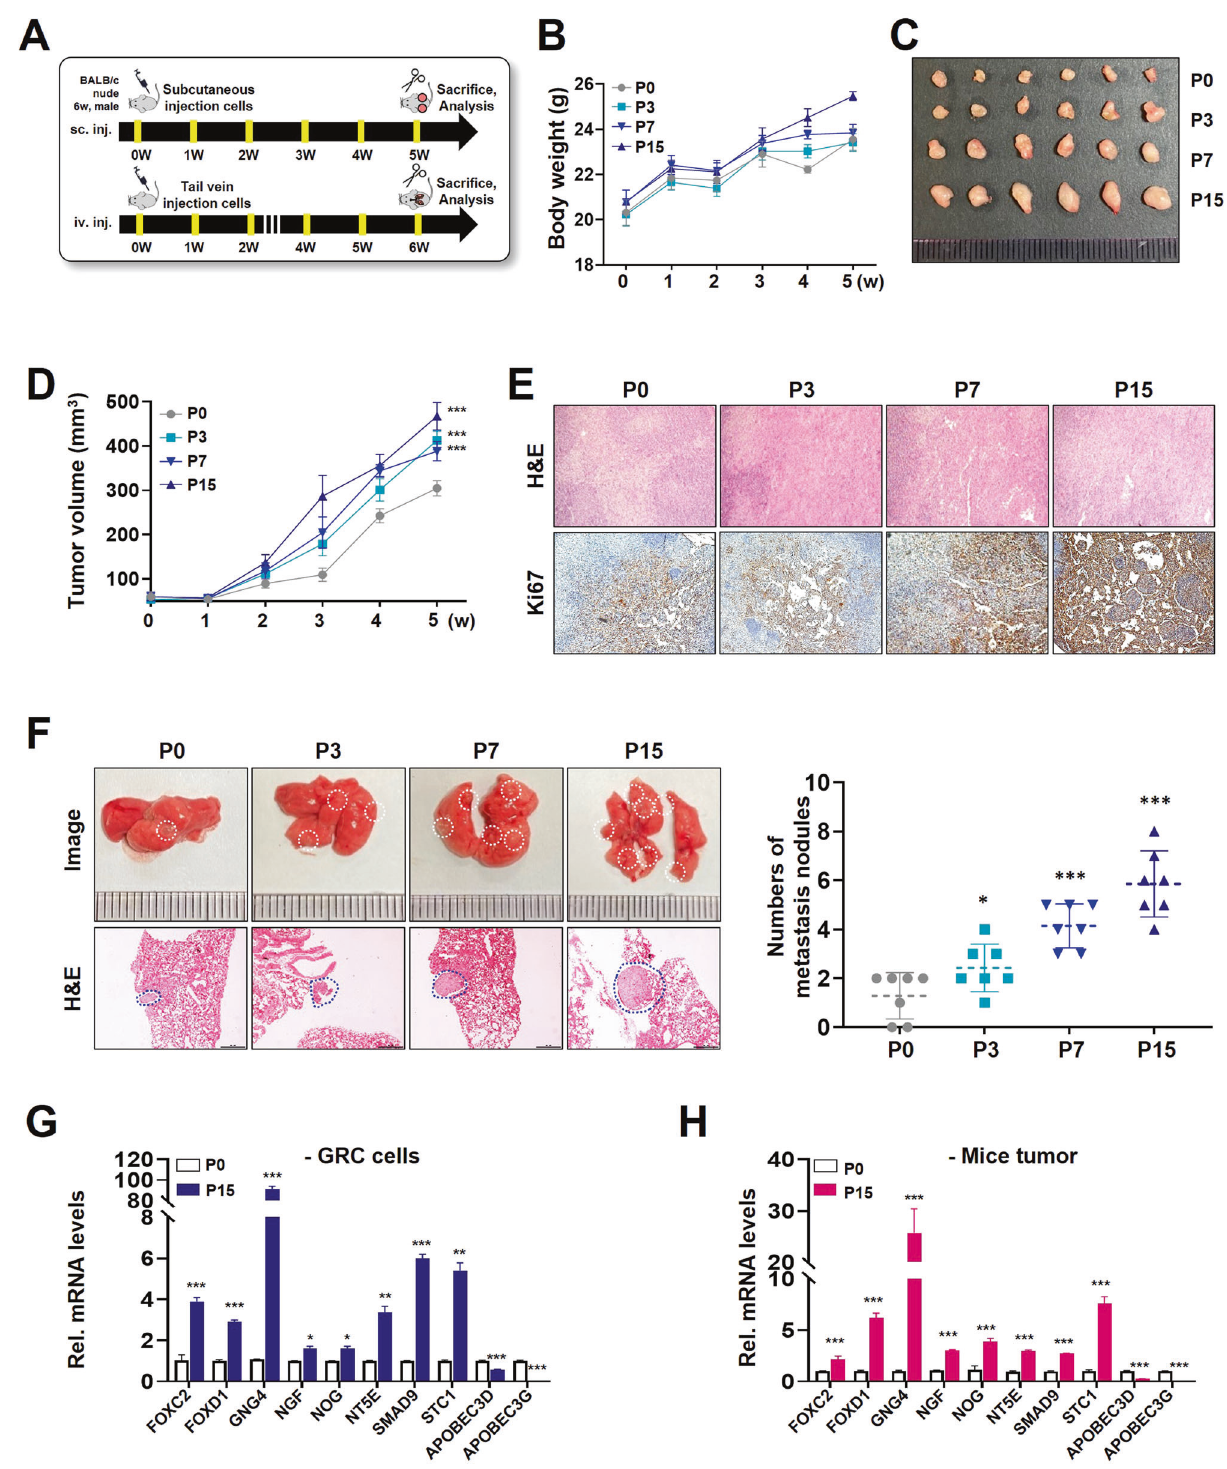
Fig. 6 Effect of the GRC1 cell line on tumor proliferation and metastasis in mice. A Schematic description of the experimental schedule. B The graph shows the mouse body weight gains after the GRC1 cell line injection. C Representative images of tumors. Tumor tissues were surgically removed from nude mice 5 weeks post-injection. D Xenograft tumor volume of mice injected with parental phase P0 and the GRC1 cell line. E Representative images of H&E and Ki-67 expression by immunohistochemistry. F Representative lung images and H&E staining were obtained after injection of the GRC1 cell line via the tail vein (left). Comparison of the number of lung metastatic nodules formed after tail vein injection of the GRC1 cell line (right). Expression and validation of 10 genes out of 23-gene signatures G in the GRC1 cell line and H in tumor xenografts by qRT-PCR. * P < 0.05; ** P < 0.01; *** P < 0.001.